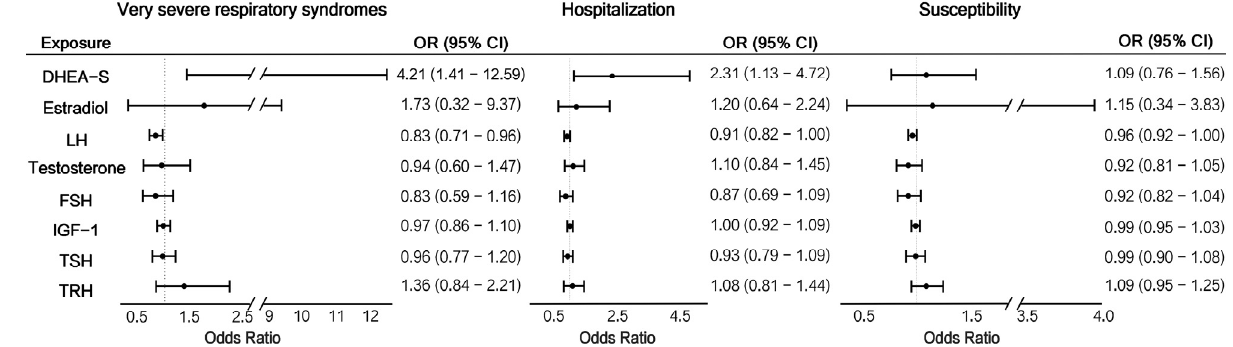
Figure 1. MR analyses the association of CNS-regulated Hormones and COVID-19 phenotypes.